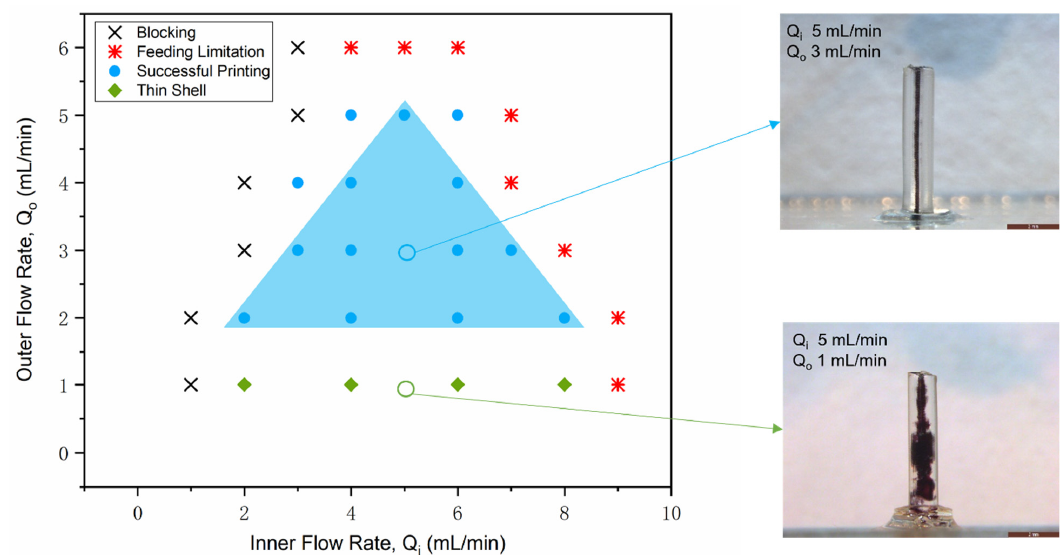
Figure 3. Process window for 3D-printed connector manufacturing, in which two typical examples of 3D-printed connectors are presented (Example 1: Q i 5 mL/min, Q o 3 mL/min inside the process window and Example 2: Q i 5 mL/min, Q o 1 mL/min outside the process window).